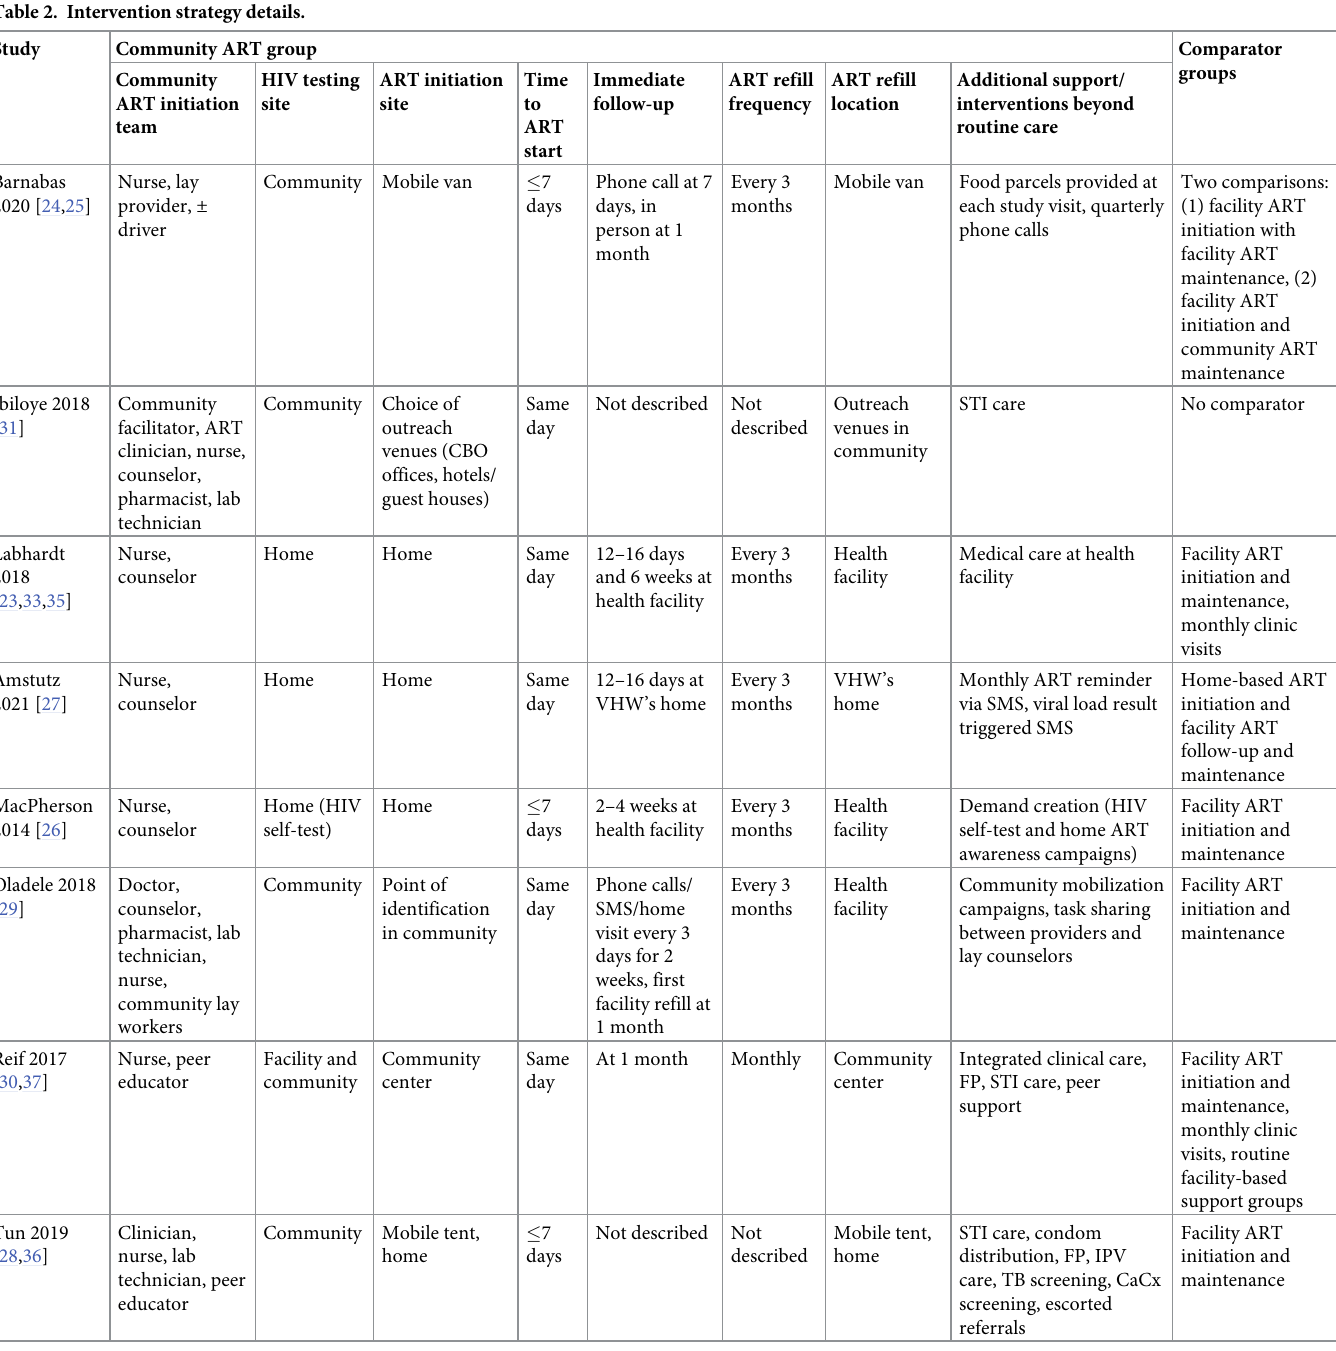
Table 2. Intervention strategy